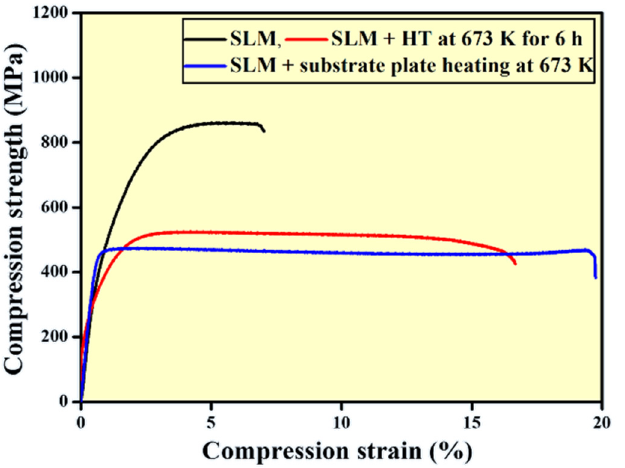
Figure 8. Compressive stress-strain plot of the Al-20Si-5Fe-3Cu-1Mg alloy at room temperature in the as-prepared SLM, SLM + heat treatment at 673 K for 6 h, and SLM with substrate plate heating at 673 K.